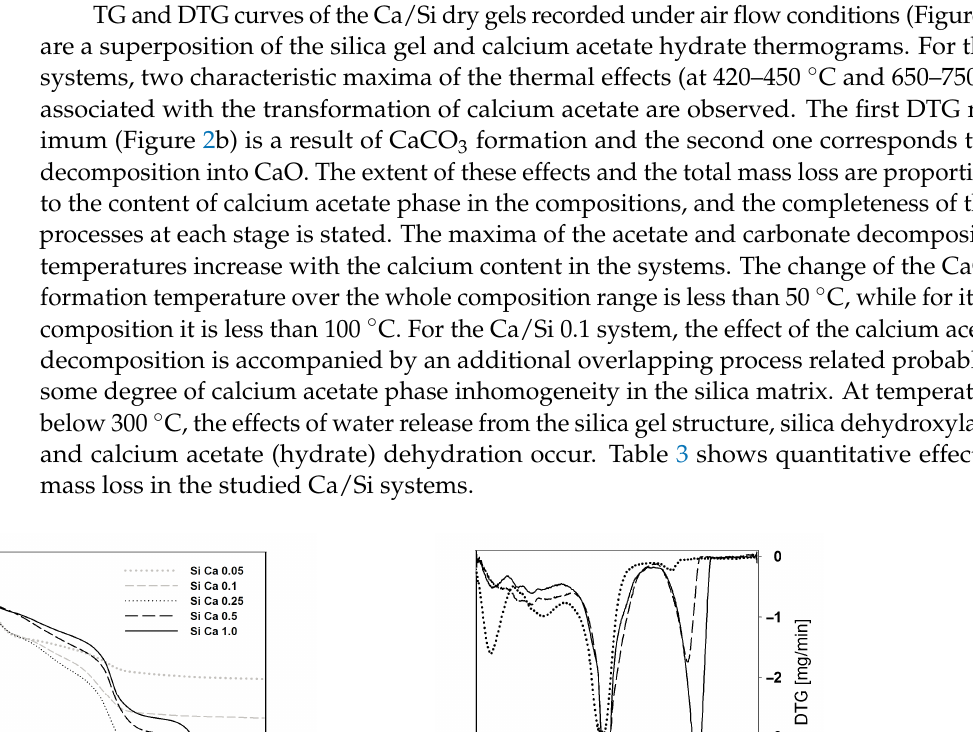
Figure 1. XRPD patterns of Ca/Si systems: ( a ) before calcination; ( b ) after calcination at 600 °C in oxygen atmosphere; ( c ) SAXS scattering of calcined samples.